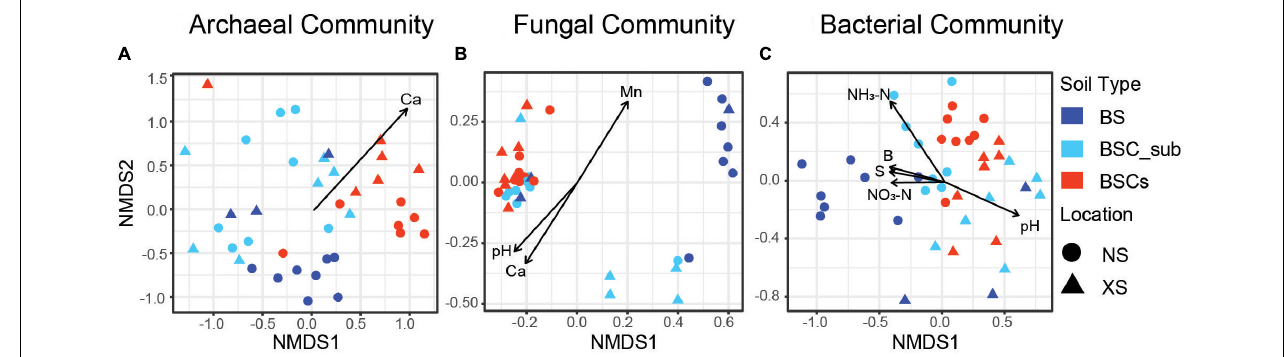
FIGURE 1 | Dissimilarity of bacterial, fungal, and archaeal compositions in biocrusts comparing to sub-surface and bare soil samples. Ordination using NMDS is derived from Bray–Curtis dissimilarity and applied to analyze the archaeal (A) , fungal (B) , and bacterial (C) communities. Circle shape represents soils from Nansha Archipelagos whereas triangle represents Xisha Archipelagos. Different soil types are color coded. The function envfit from the R vegan package was used to fit environmental vectors onto the ordination (environmental factor significant correlation with NMDS, P < 0.05). NMDS, non-metric multidimensional scaling; NS, Nansha Archipelagos; XS, Xisha Archipelagos; BS, bare soil; BSC_sub, biocrust subsurface soil; BSCs, biocrusts; Mn, soil available manganese; NO 3 -N, soil nitrate nitrogen; NH 3 -N, soil ammonia nitrogen; B, soil available boron; S, soil available